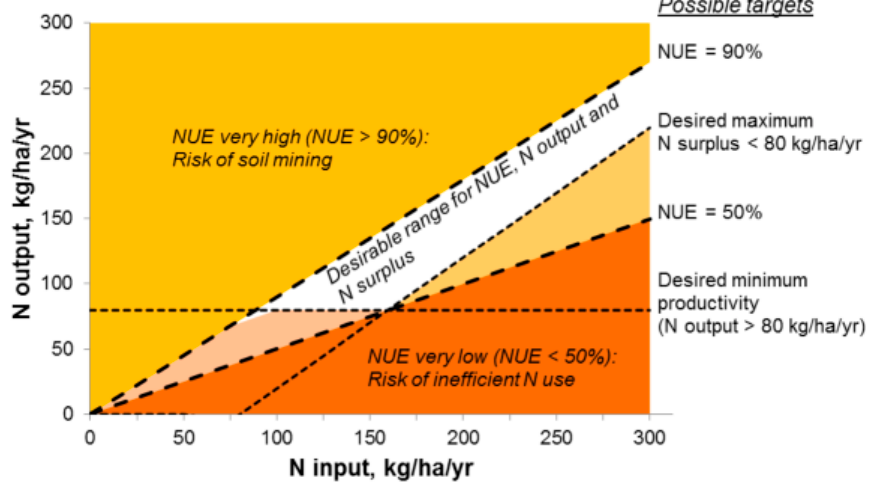
Figure 3. Concept of the NUE indicator: a two-dimensional N input–N output diagram. Shows three ranges of possible NUE values for cropping systems (0–50%, 50–90%, and >90%) with a minimum desired N output (80 kgN/ha/year) and a maximum desired surplus of 80 kgN/ha/year [52]. With permission from the EU Nitrogen Expert Panel (Oene Oenema).